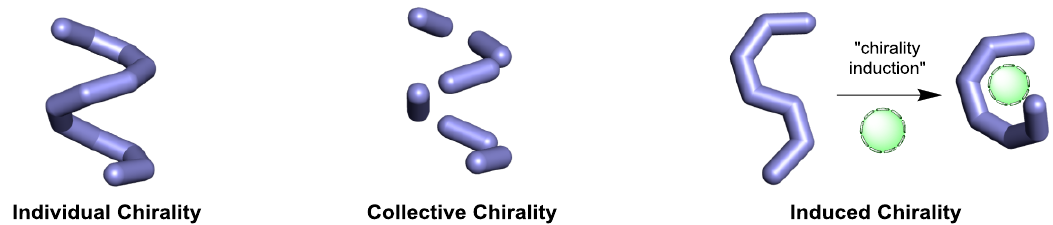
Figure 4. Different strategies to chiroptical systems.